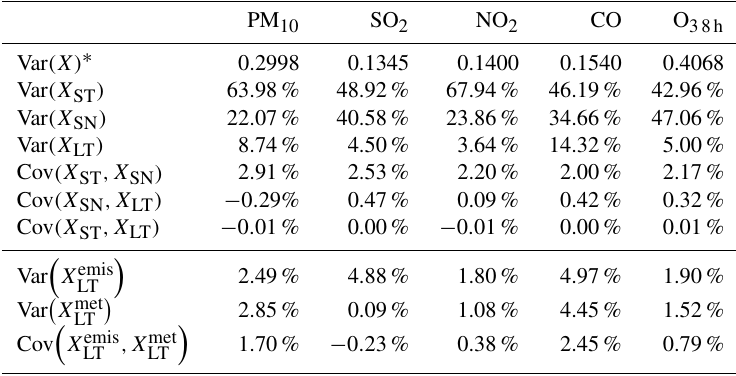
Table 2. Correlation coefficients ( r ) between baseline time series of pollutants (PM 10 , SO 2 , NO 2 , CO, and O 38h ) and meteorological variables ( T , T max , P , RH, WS, and SI), and adjusted R 2 between the baseline time series of pollutants ( X BL ) and multiple-linear-regression model ( a 0 + P i a i MET BL ). i Correlation coefficients ( r ) T BL − 0 . 481 ∗ − 0 . 785 ∗ between X BL and MET BL T max